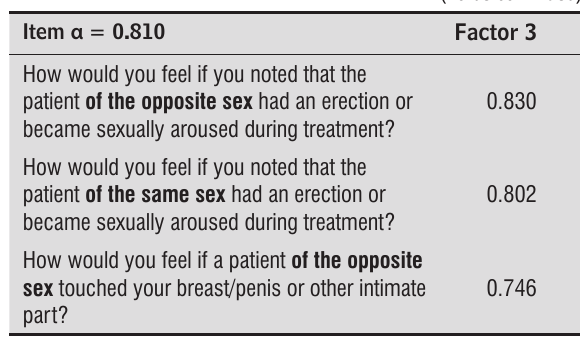
Table 3 - Factor analysis from the extraction of the